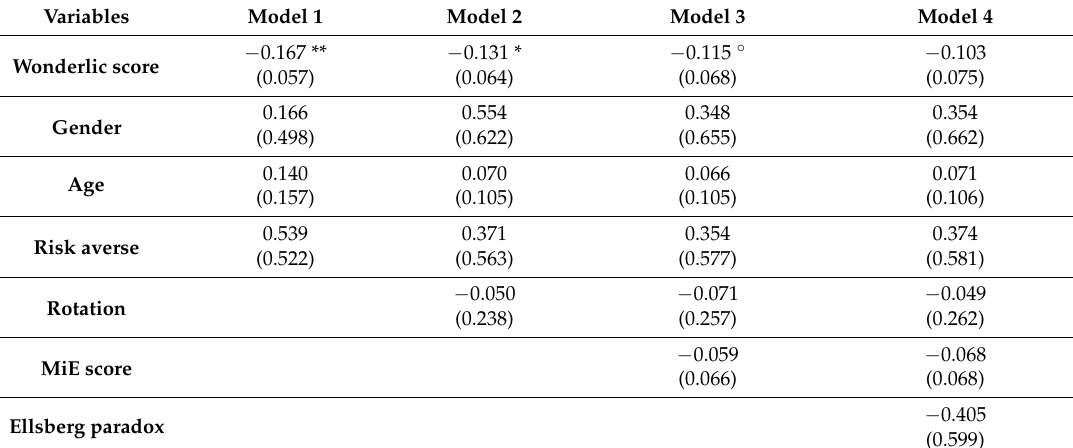
Table 5. Ultimatum game regression models (Ordered Logit